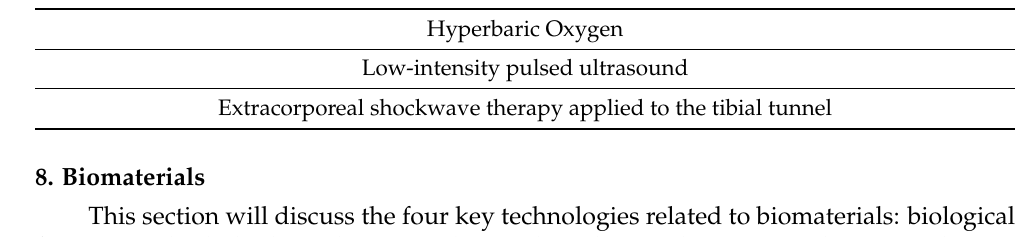
Table 5. Biophysical and environmental methods used in anterior cruciate ligament